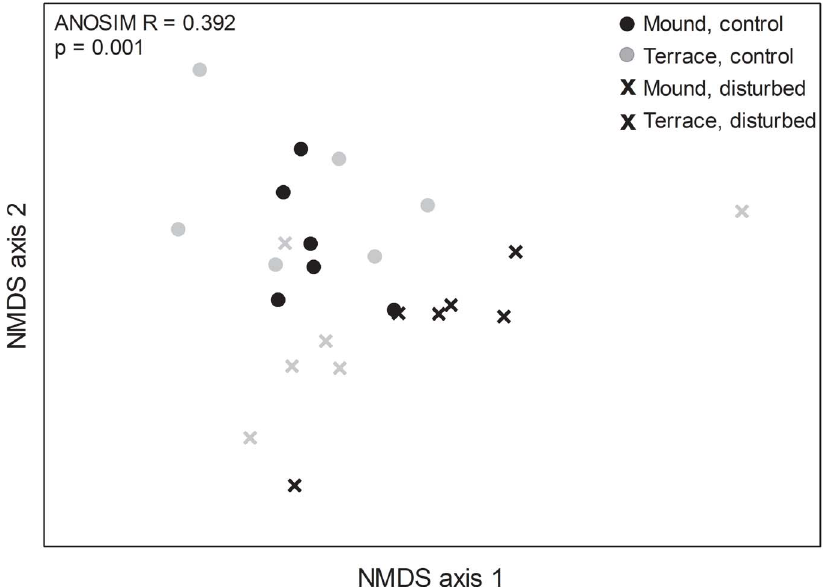
Figure 5. Disturbance and patch size effects on arthropod community composition. Composition of emergent marsh arthropod assemblages in response to disturbance treatment (disturbed, control) and habitat patch size (mounds, terraces). The nonmetric multidimensional scaling (NMDS) ordination is a representation of dissimilarities among treatments based on a Bray-Curtis similarity matrix. Results from ANOSIM are shown.